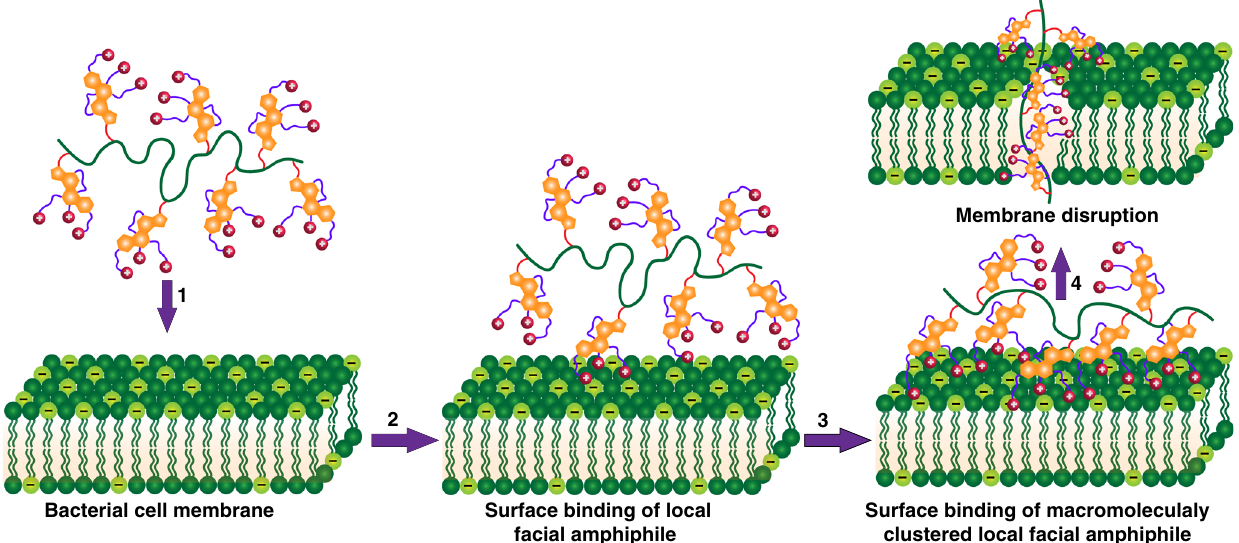
Fig. 8 A proposed mechanism of action of cholic acid-based polymers on the bacterial cell membrane: 1 diffusion, 2 surface binding, 3 membrane insertion and 4 membrane disruption. The illustrated cholic acid can be replaced by other multicyclic compounds that are modi fi ed with facial